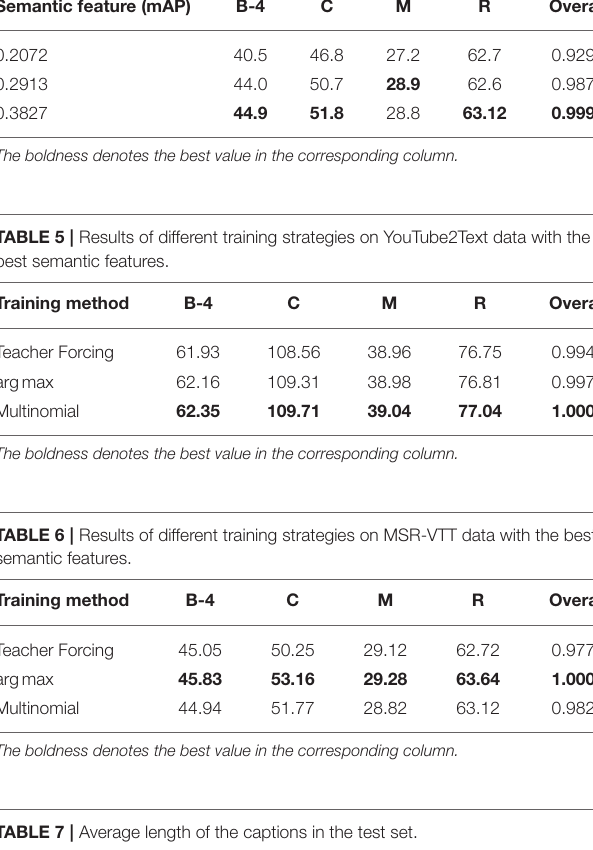
TABLE 7 | Average length of the captions in the test